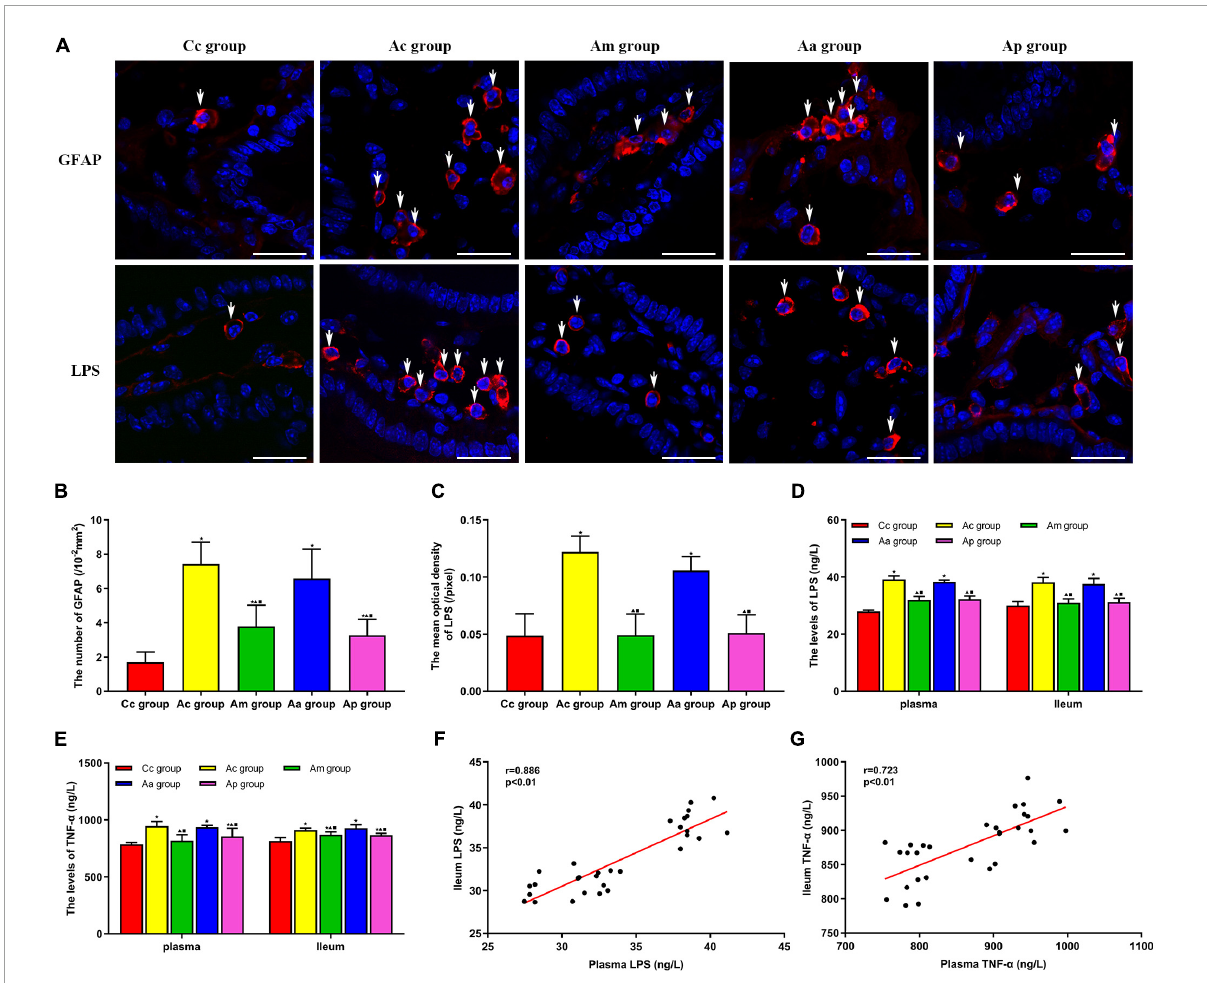
FIGURE5 Results of the expression of GFAP, lipopolysaccharide (LPS), and TNF- α in serum and the intestine in each group ( n = 6, mean ± SD). (A) Representative images of immunofluorescence (IF) staining of LPS (red) and GFAP (red) in each group, the positively stained cells are shown with white arrows, and scale bar is 25 µ m. (B) Comparison between the number of cells expressing GFAP of all groups. (C) Comparison between the mean optical density of LPS of all groups. (D,E) Comparison between the contents of LPS and TNF- α in the serum and intestine of all groups. A one-way analysis of variance (ANOVA), followed by the LSD multiple-range test, was used with exceptions when comparing the number of cells expressing GFAP and the contents of LPS in serum, which were analyzed by the Kruskal–Wallis test. LSD-t and chi-square are presented in Supplementary Tables 5–7 . (cid:70) P < 0.01 or P < 0.05 compared with the C57BL/6 control (Cc) group. (cid:78) P < 0.01 or P < 0.05 compared with the APP/PS1 control (Ac) group; (cid:4) P < 0.01 or P < 0.05 compared with the APP/PS1 antibiotic + manual acupuncture (Aa)